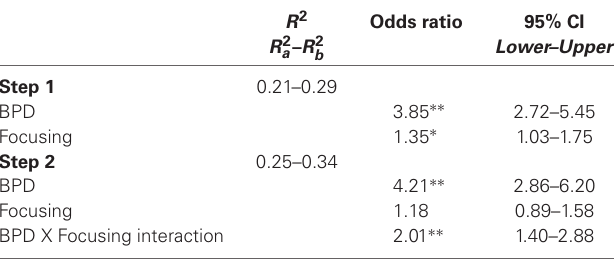
Table 4 | Hierarchical Logistic Regression testing interaction effects of BPD features and focusing on prior incidence of self-harm .